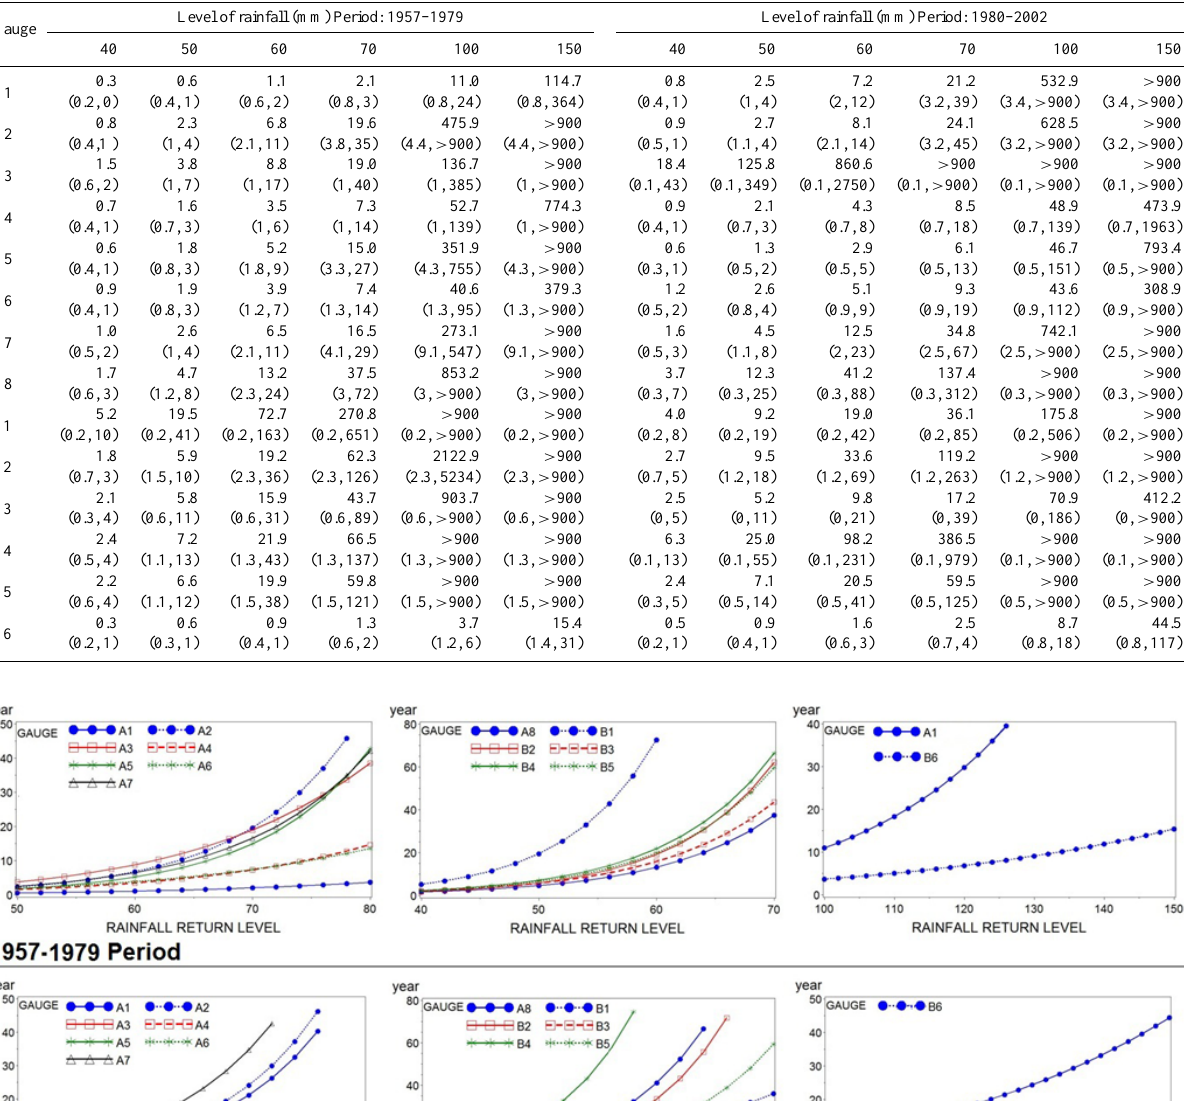
Table 7. Estimate return time (year) and their 95% confidence intervals for different rainfall levels (mmday − 1 ). Gauge